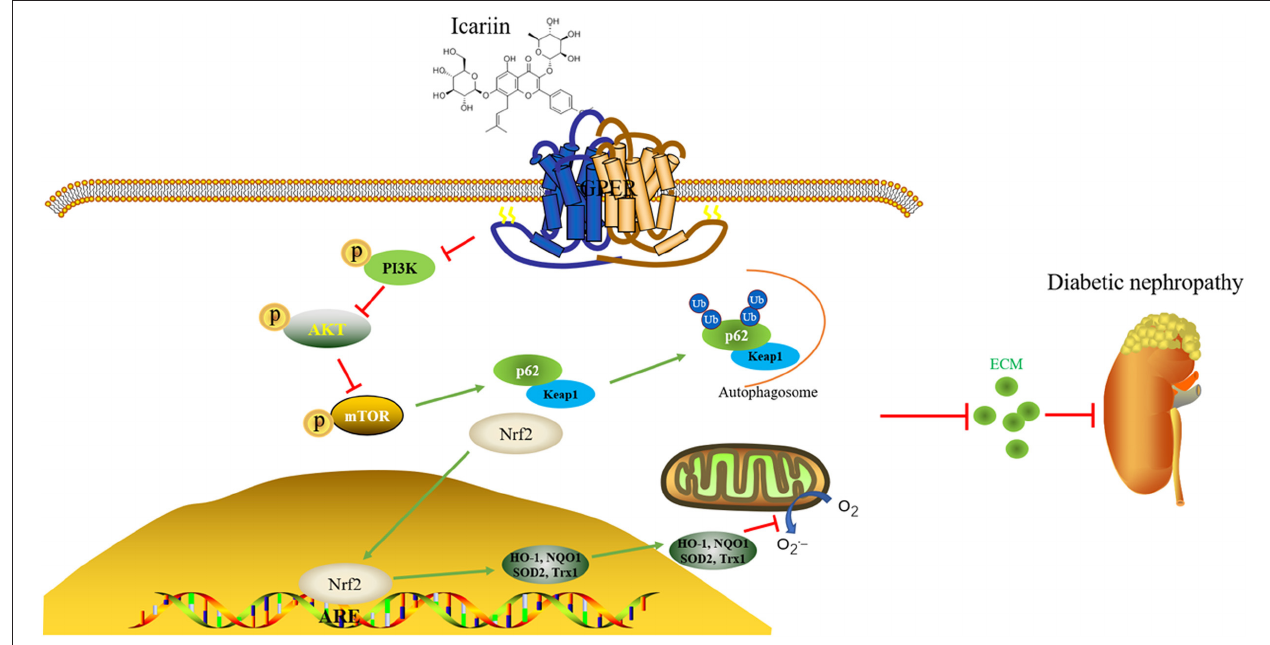
FIGURE 10 | Mechanisms for the anti-diabetic kidney disease (CKD) effect of icariin.